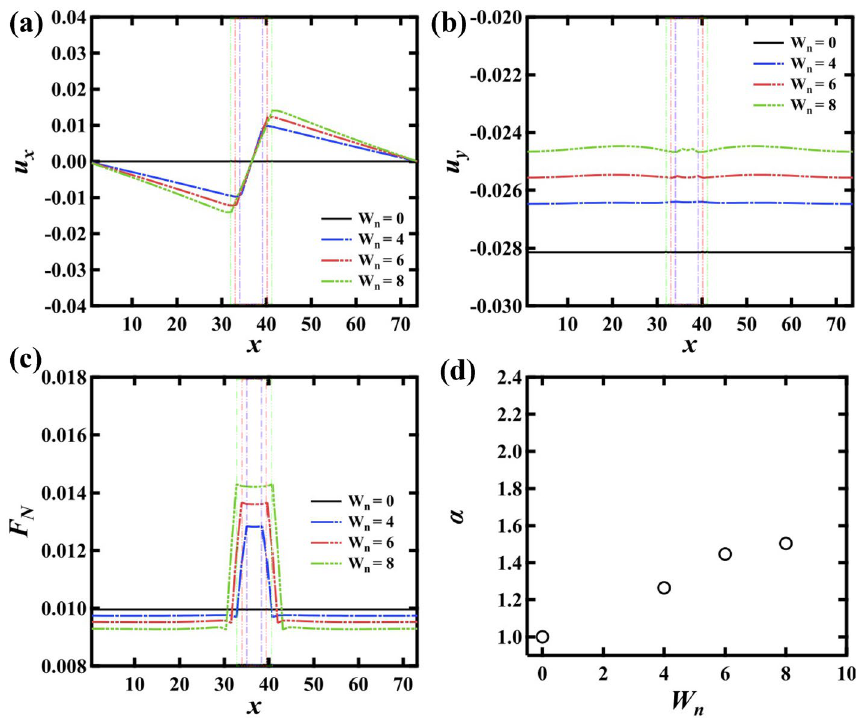
Figure 2. ( a ) Displacement in the x axis direction u x and ( b ) displacement in the y axis direction u y at n y = 12 . The vertical dashed lines represent the interfaces between G h region and G s region. u x has a positive correlation with x in the G h region. Meanwhile, u y is almost constant. ( c ) The normal force F N on the bottom surface. ( d ) The ratio of the normal stress at G h region to that at G s region α . α increases with increasing W n